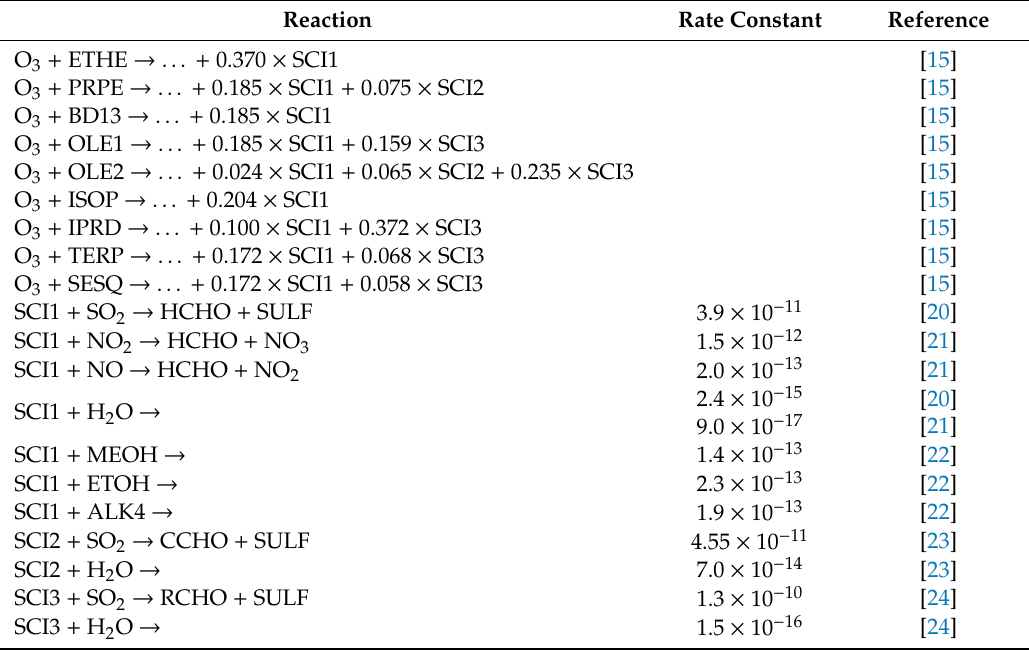
Table 1. Reactions involving the three stabilized Criegee intermediates (SCI) species on SAPRC07 adapted in this